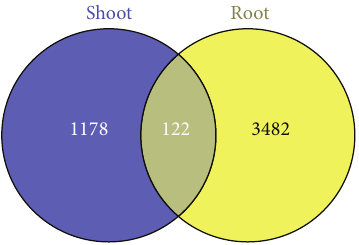
Figure 5: Venn diagram of the distribution of differentially expressed transcripts in shoot and root